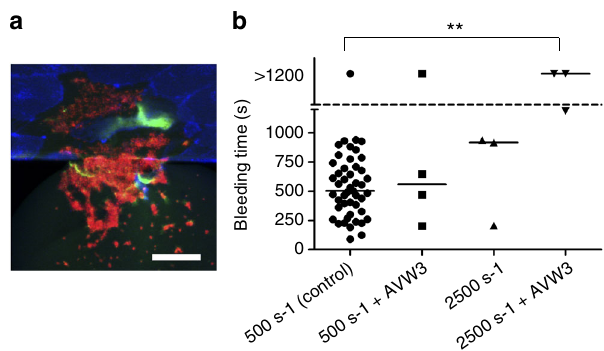
Fig. 3 Functional inhibition of vWF causes prolonged bleeding in high shear conditions. a vWF (green) co-localizes with injured endothelial cells as well as with platelets. Endothelial cells are stained with plasma membrane stain (blue) while platelets are stained with anti-CD41 (red). b When healthy blood was treated with the AVW3 antibody, which binds and inhibits the A1 domain of vWF, we observed prolonged bleeding time only at arteriolar (2500 s − 1 ) shear rates comparted to venular shear rates (500 s − 1 ). One- way ANOVA indicate statistically signi fi cant difference among these four conditions, and Dunn ’ s multiple comparison test further show that bleeding times are signi fi cantly different between the 500 s − 1 control and 2500 s − 1 with AVW3 conditions (**). Scale bar = 50 µ m. Bars in graph